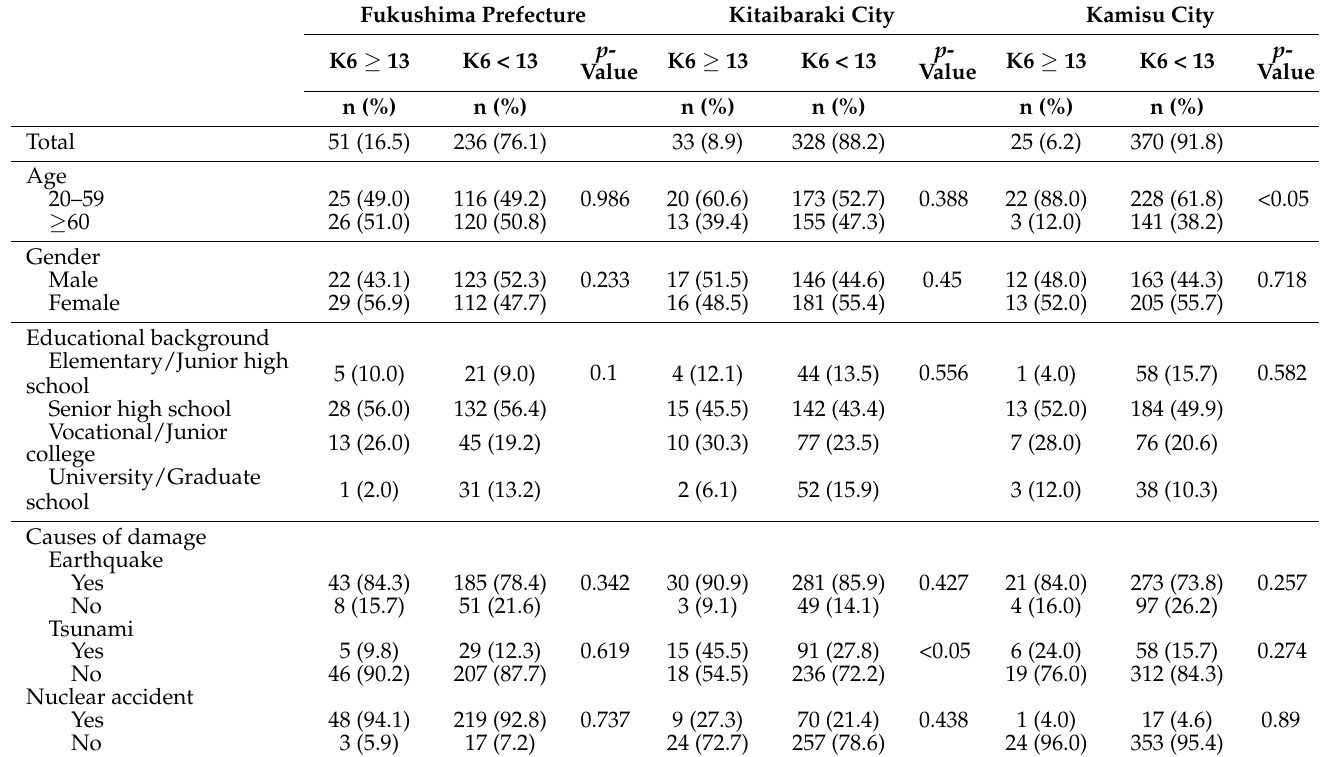
Table 2. The Kessler Psychological Distress Scale (K6) of three regional groups depending on the participants’ attributes and damage